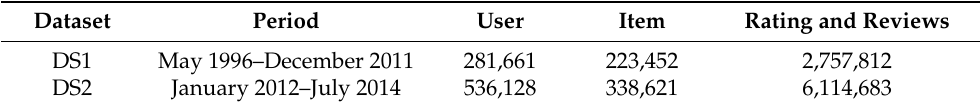
Table 3. Descriptive statistics of the two